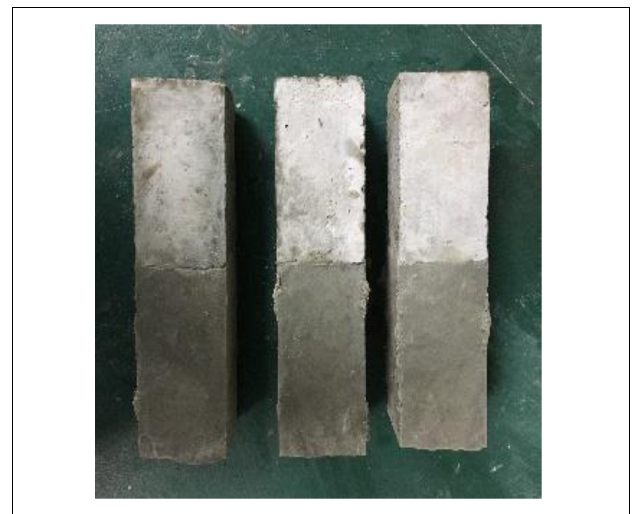
FIGURE 3 | Final product of the two-halves (CSA-ECC/mortar) specimens.